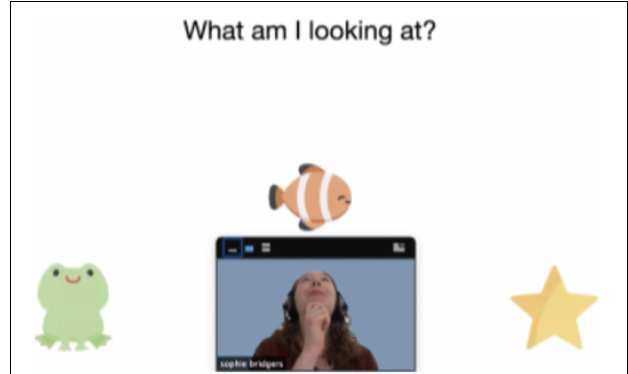
FIGURE 1 | An example screenshot of a moderated session using Zoom. By positioning the experimenter’s video relative to stimuli presented via screen-sharing, the experimenter can use gaze and pointing to elicit joint attention or refer to specific stimuli, similar to how she would use gaze or pointing during in-person interactions. In this example, the participant (or the parent) was instructed to position the experimenter’s video at the bottom of the screen; the experimenter can then “look” at one or more objects on screen and ask the participant to report what she is looking at. Interactions like